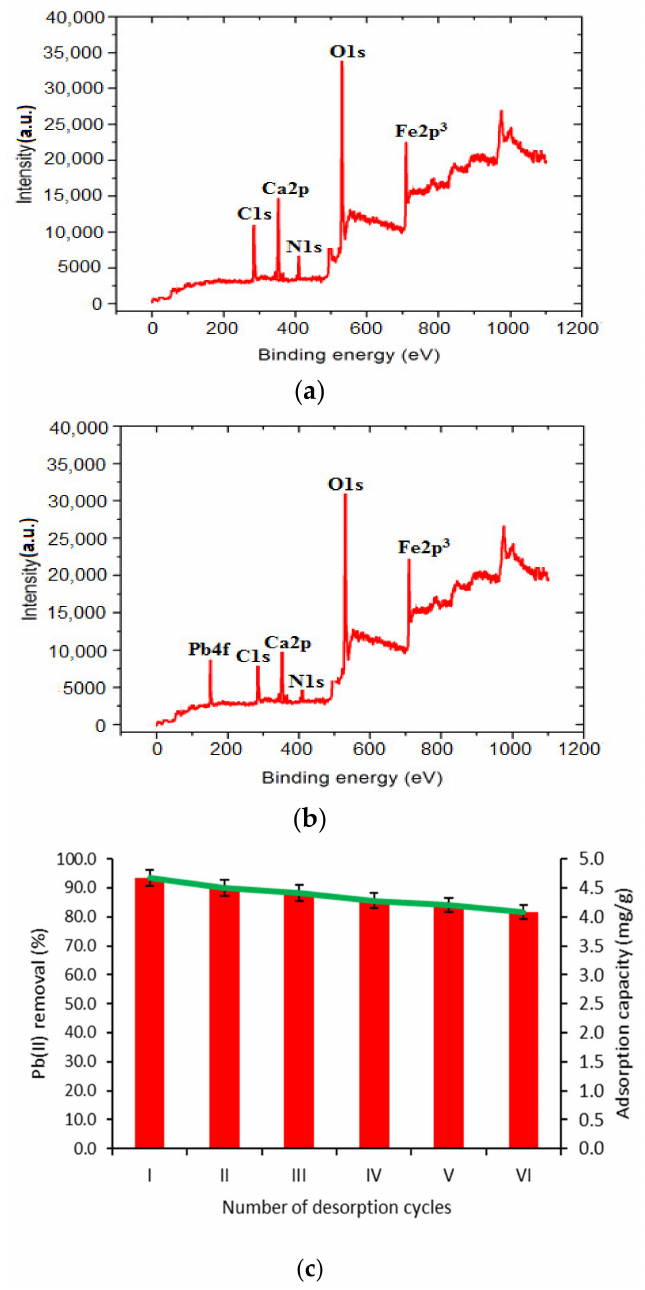
Figure 9. XPS spectra of ( a ) CaFe 2 O 4 -NGO, ( b ) Pb(II) adsorbed CaFe 2 O 4 -NGO and ( c ) removal of Pb(II) ions vs. desorption cycle sing CaFe 2 O 4